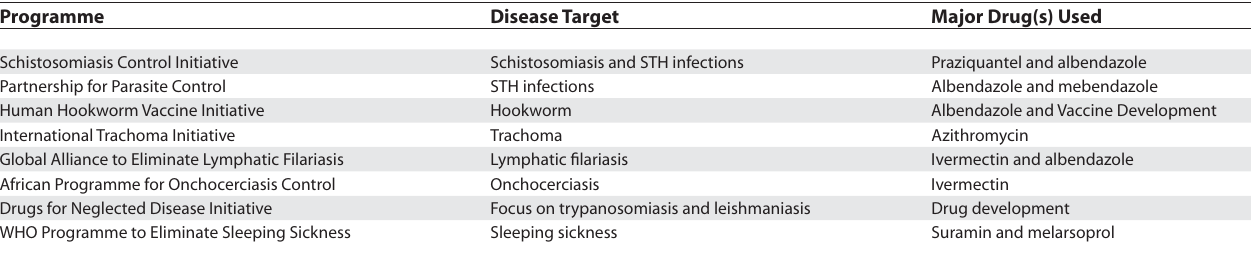
Table 2. PPPs Engaged in Vertical Programmes for Neglected Tropical Disease Control in Africa Programme